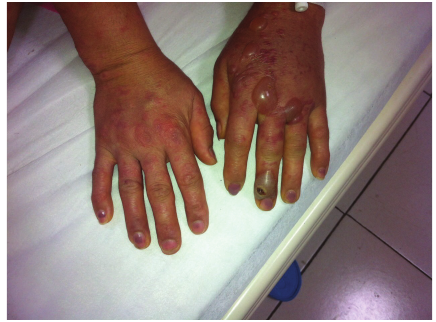
Figure 5: Hand lesions, 2 days after hospitalization.